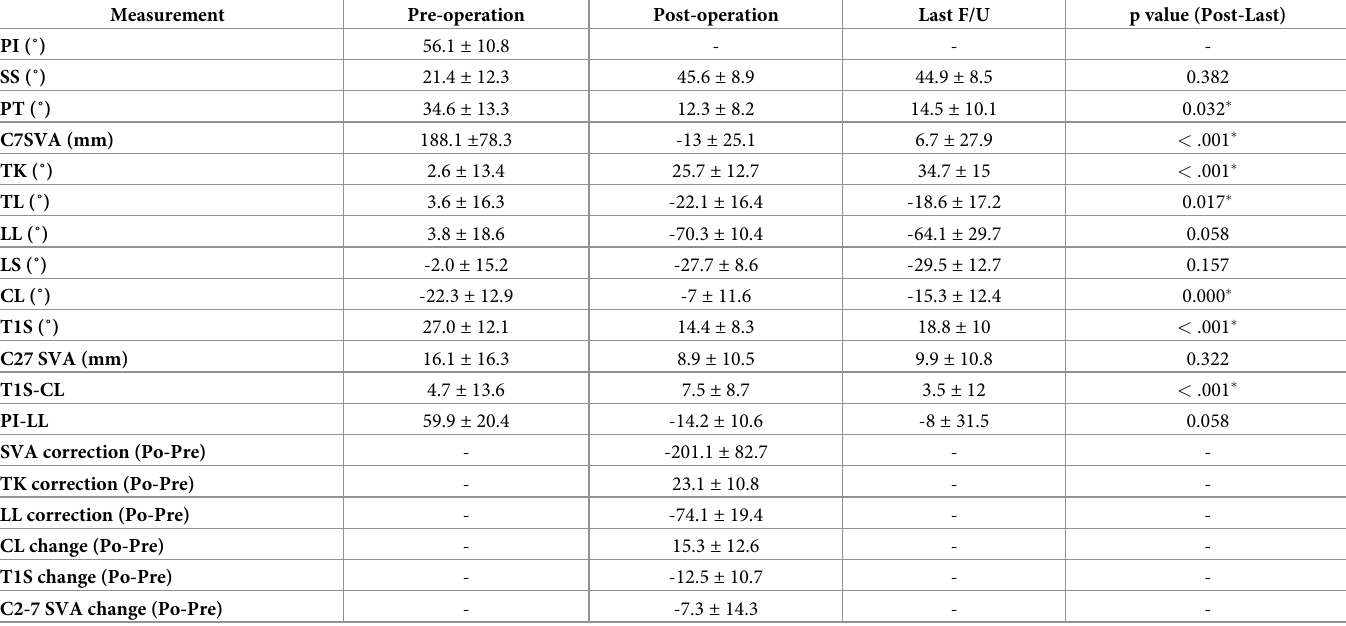
Table 2. Radiographic parameters preoperatively, postoperatively, and at last follow-up. Measurement